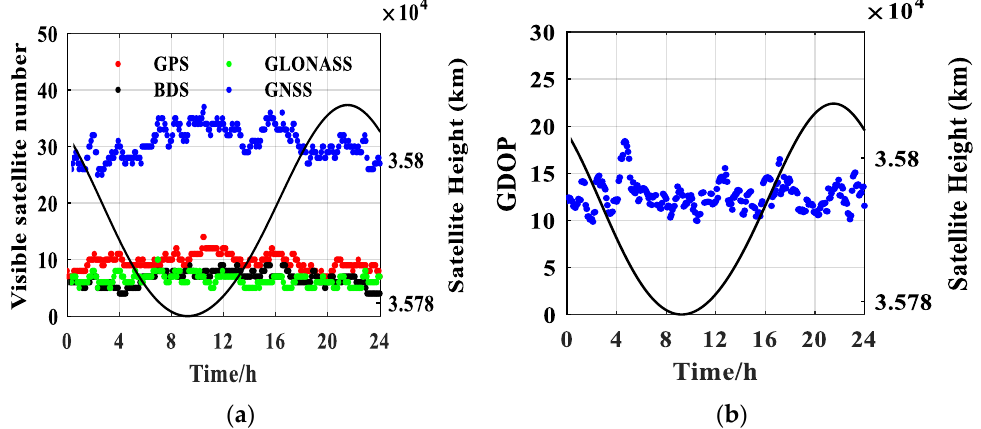
Figure 4. Visible GNSS number and GDOP of antenna 1. ( a ) Visible GNSS number of antenna 1. ( b ) GDOP of antenna 1.